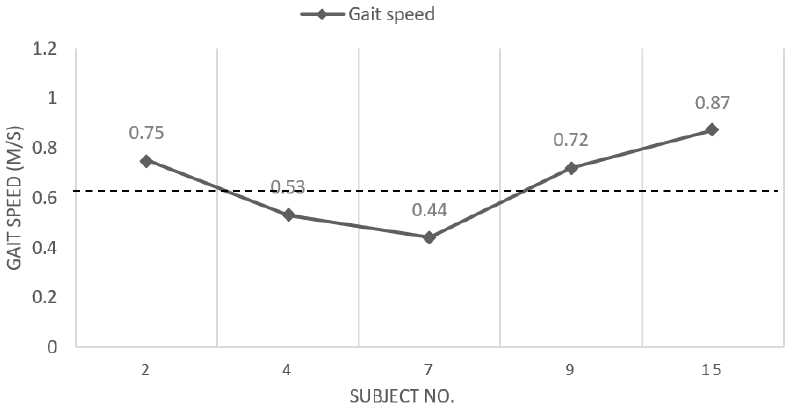
Figure 1. Gait speed of subjects with falls. The dashed line represents gait speed of 0.6 m/s, which is considered as the cutoff for predicting falls [35–37].